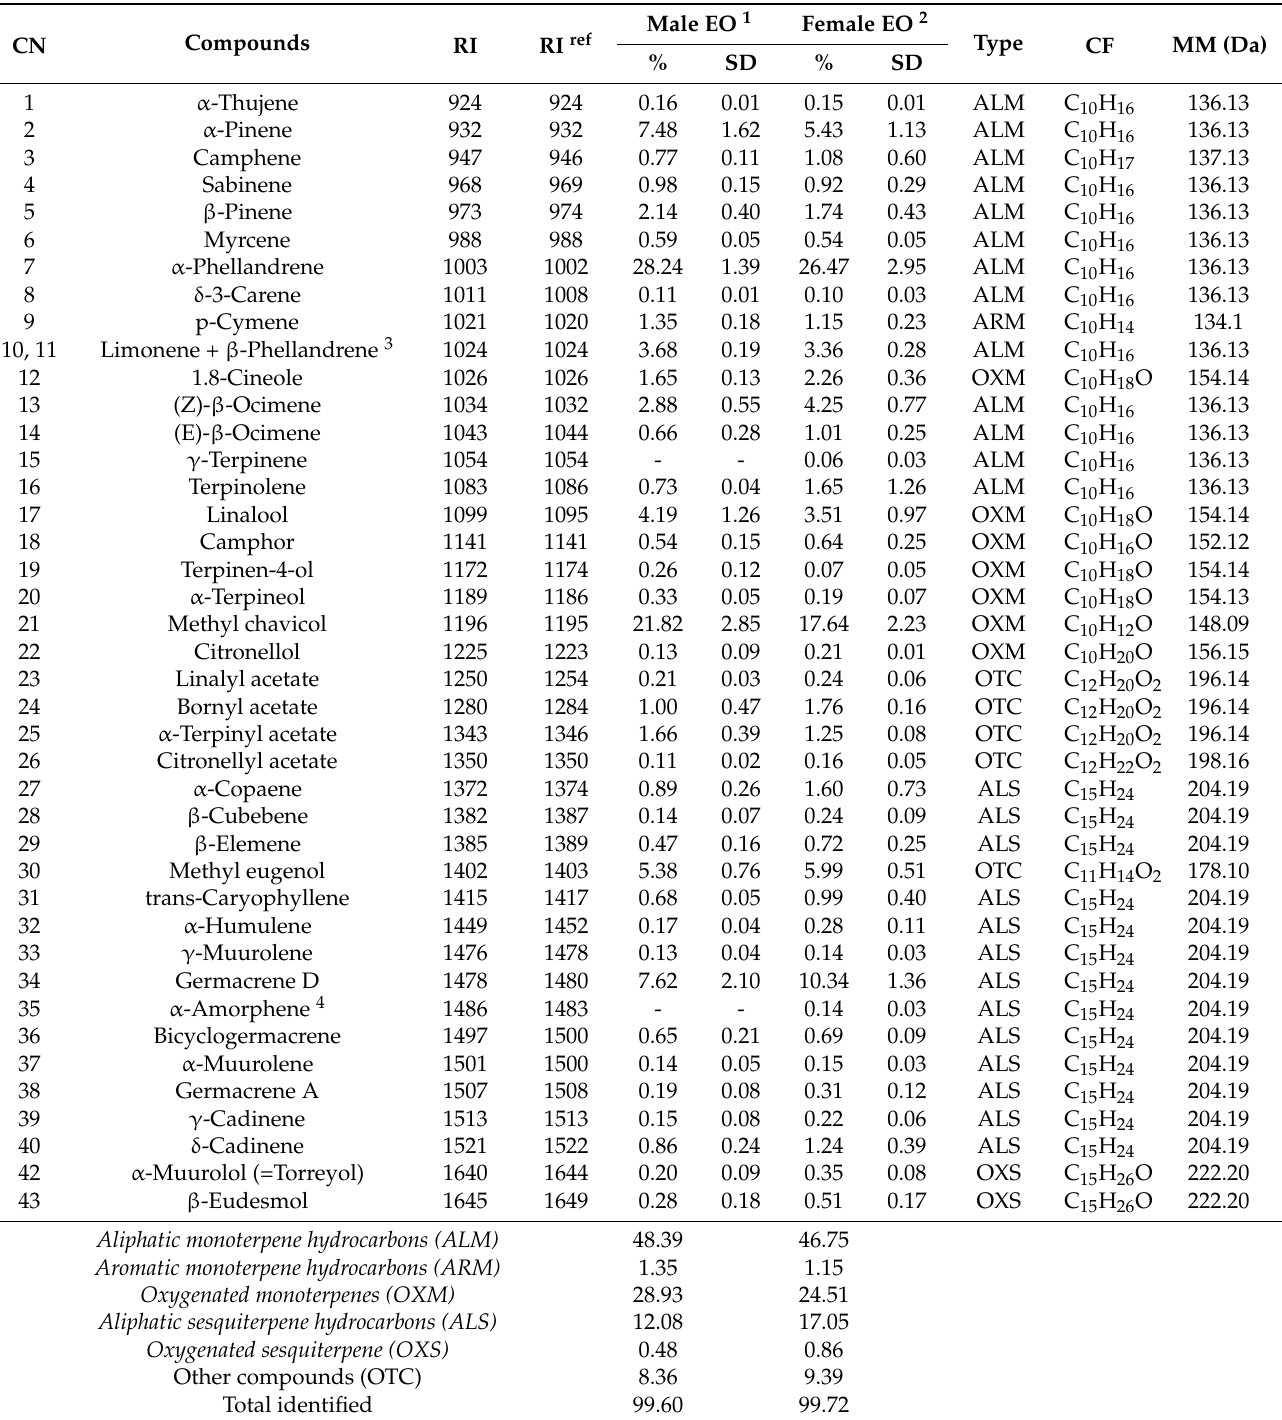
Table 2. Chemical compounds present in the essential oil of Hedyosmum racemosum leaves identified using the non-polar column DB-5